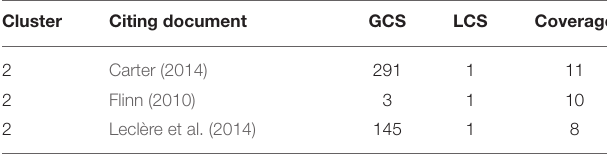
TABLE 3 | Citing documents in cluster #2 identified using the DCA.